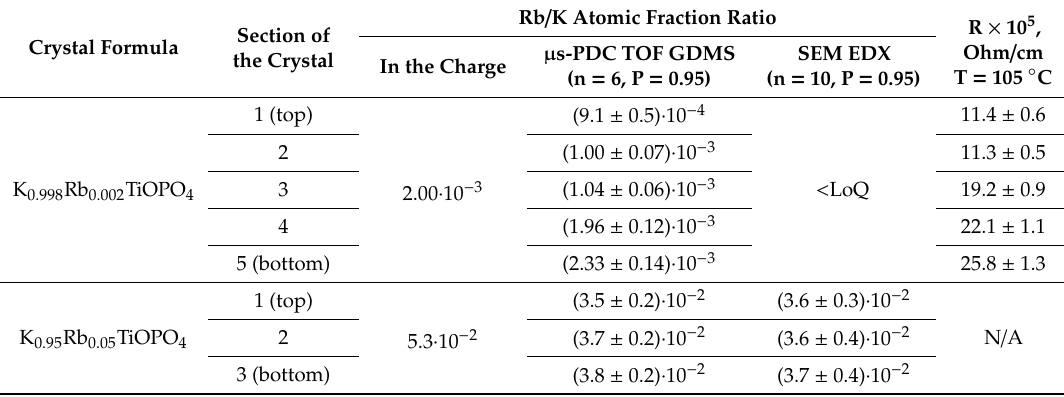
Table 2. Atomic fraction ratios of Rb / K in K 1 − x Rb x TiOPO 4 crystals (x = 0.002 and 0.05), determined by scanning electron microscope-energy dispersive X-ray spectroscopy (SEM EDX) and microsecond direct current pulsed glow discharge time-of-flight mass spectrometry ( µ s-PDC TOF GDMS) along the crystallographic growth axis from the crystal’s top (seeding side—1) to its bottom (opposite side—5 and 3 for K 0.998 Rb 0.002 TiOPO 4 and K 0.95 Rb 0.05 TiOPO 4 , respectively). Sample N0 was used for measurements of Rb distribution along the growth axis [001] for the K 0.998 Rb 0.002 TiOPO 4